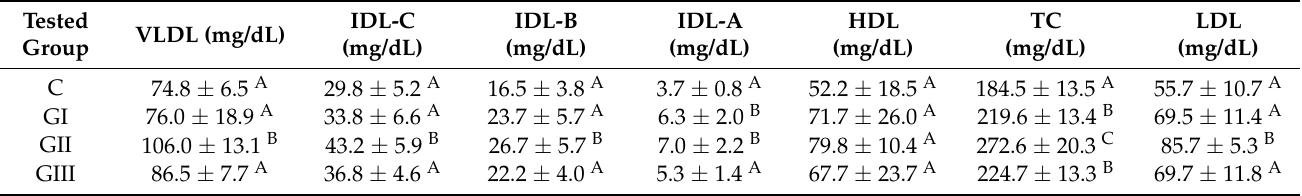
Table 5. Serum lipid profiles in a rat model after feeding a high-cholesterol diet supplemented with Chlorella powder and/or B. animalis subsp. lactis BB-12 for 8 weeks.